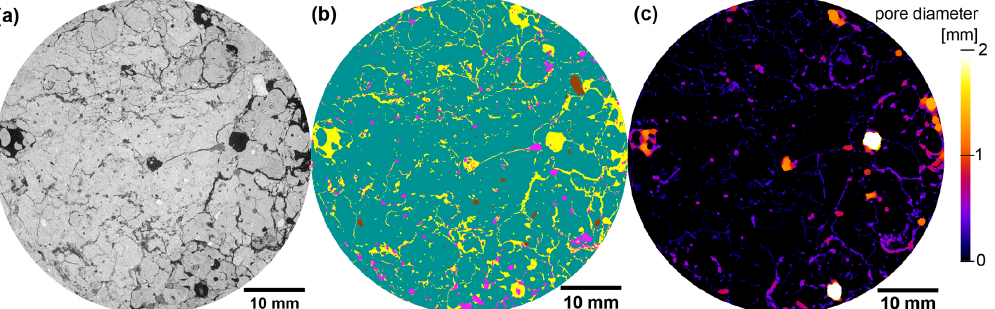
Figure 1. Visualization of image processing steps for a 2D section of an X-ray CT image from (a) the grayscale data to (b) image segmen- tation results based on supervised, machine-learning-based segmentation (pores yellow, POM pink, matrix green, rocks brown) and (c) pore diameters based on local thickness. The sample was selected from an extensive pasture plot.